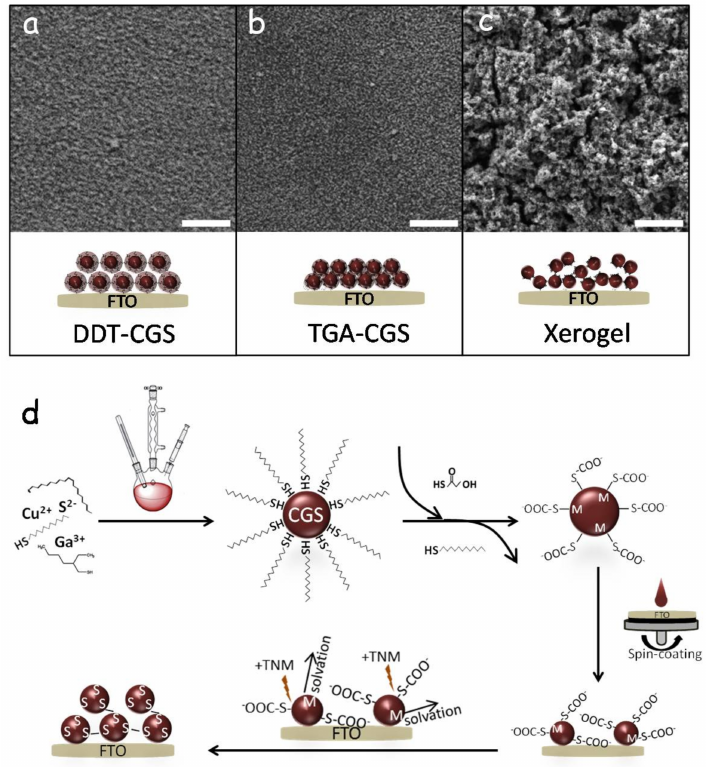
Figure 3. ( a – c ) representative SEM micrographs and schematic representations of the CGS layers produced via spin-coating of DDT-CGS ( a ), TGA-CGS ( b ), and TGA-CGS after undergoing oxidative assembly with TNM to form a xerogel film ( c ). Scale bars = 1 µ m; ( d ) schematic representation of the procedure to produce porous xerogel NC films by removal of the thiol ligand through a non-oxygen transferring oxidant,